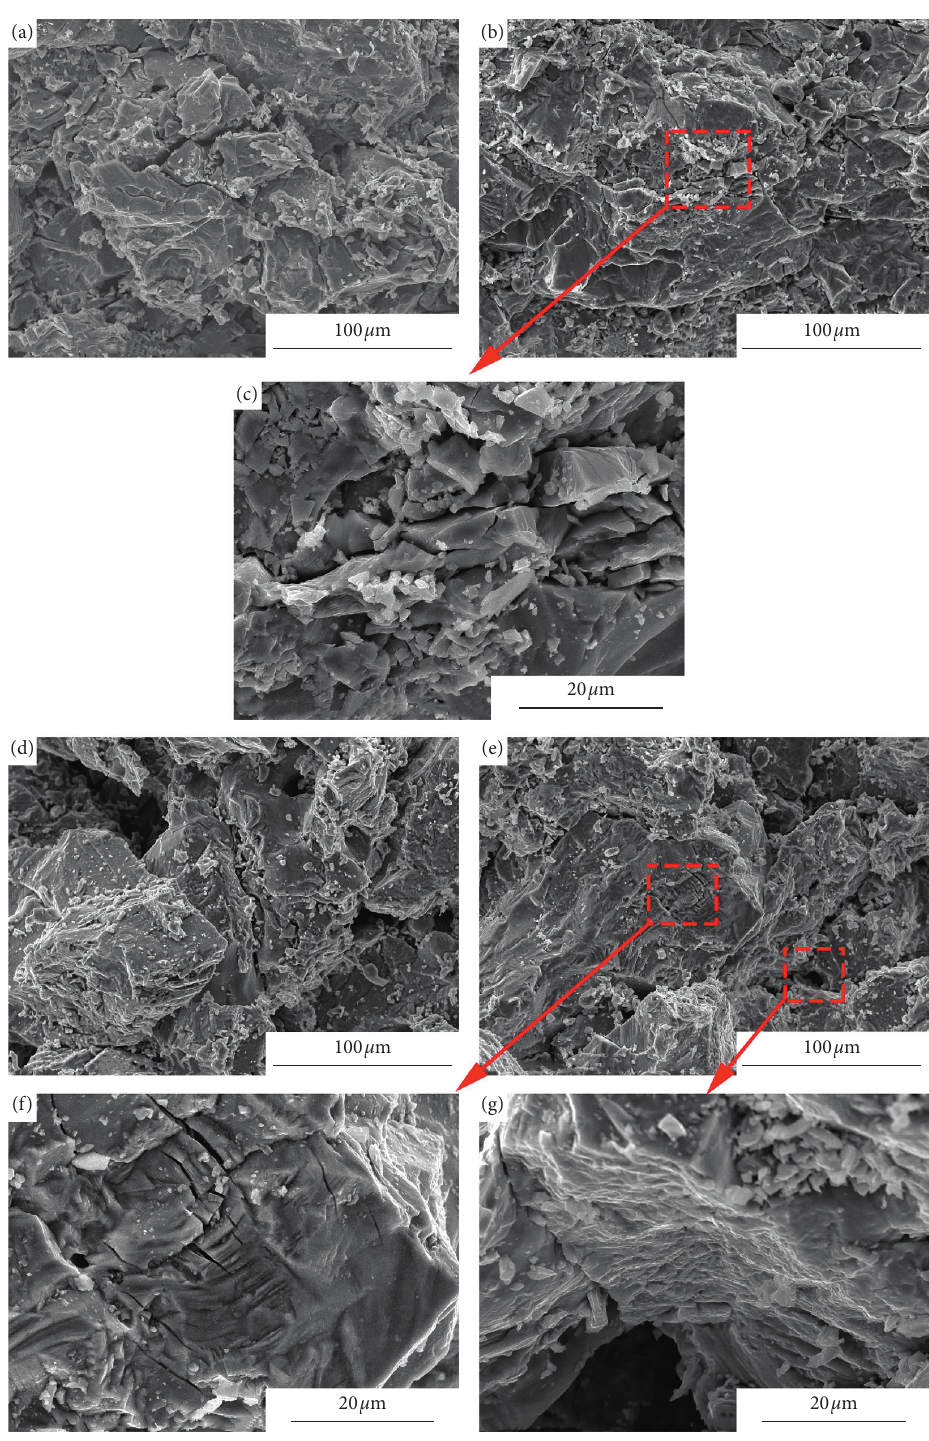
Figure 10: SEM of green compacts: (a) TiH 2 300 MPa, (b) TiH 2 800 MPa, (c) TiH 2 800 MPa (high multiple), (d) HDH titanium 300 MPa, (e) HDH titanium 800 MPa, and (f and g) HDH titanium 800 MPa (high